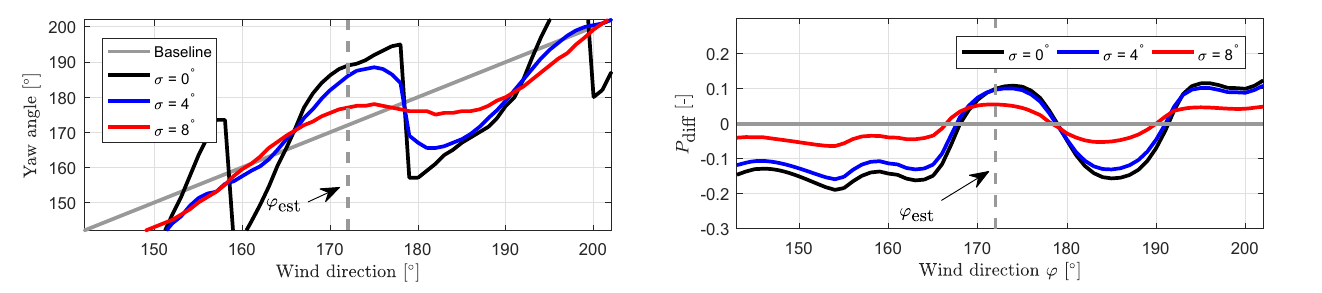
Figure 8. Optimized yaw angles of the reference wind turbine for ϕ est .